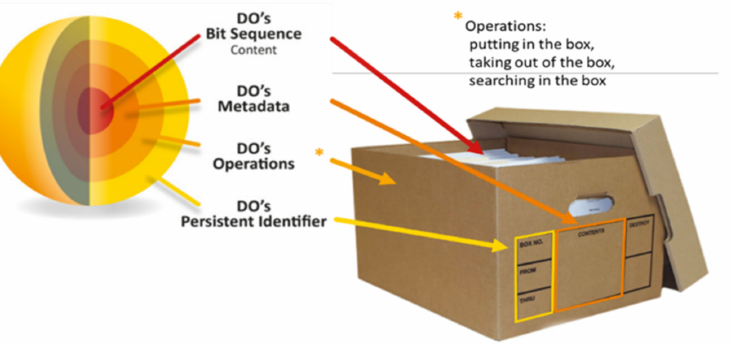
Figure 2. Based on a suggestion from A. Hardisty, this figure shows the similarity between the old post-box sent by postal offices spread across the world and the Fair Digital Object. The post-box has external information (IDs, metadata, etc.) that is needed to tell officers where the box should go to and it has internal information only accessible for the addressee. In similar ways, the FDO contains all necessary information and makes the distinction between external and internal